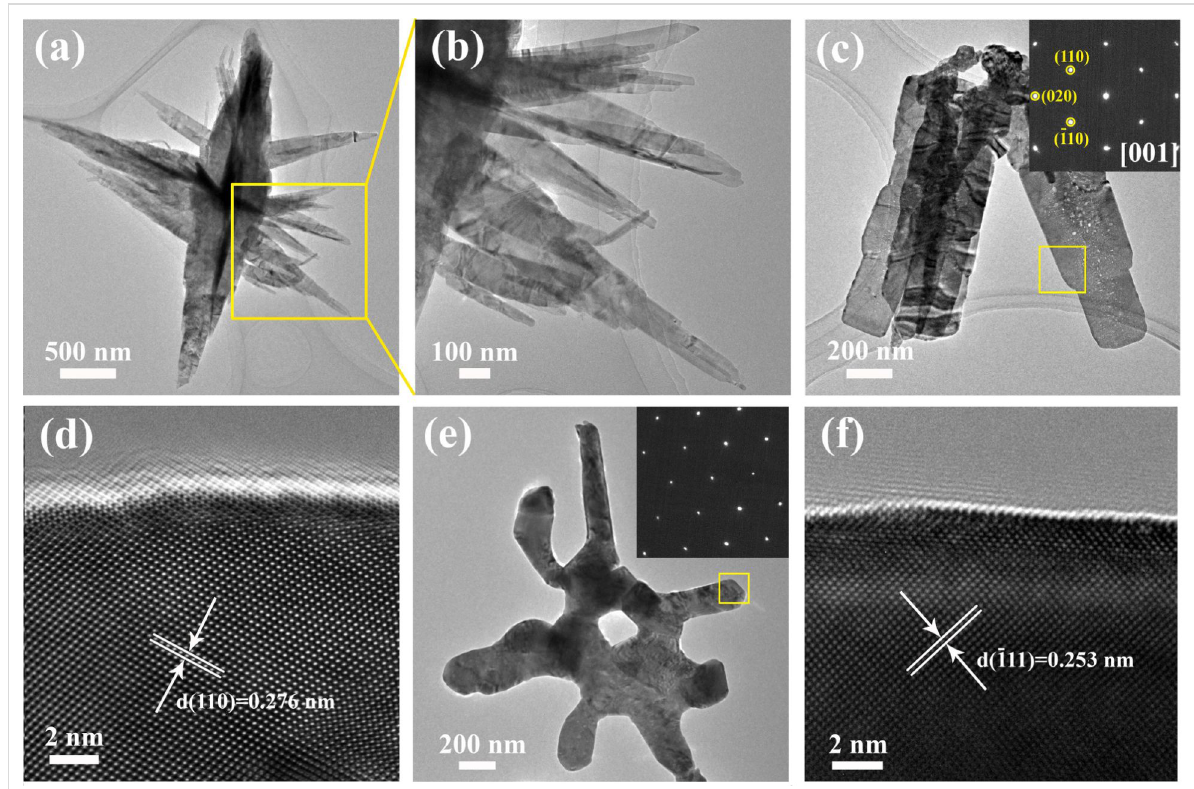
Figure 2: CuO catalyst characterization. (a,b) TEM images of CuO NWs; (c) TEM image of CuO NBs (inset is the SAED pattern of the selected yellow square area); (d) HRTEM along the [1] direction; (e,f) TEM images of a CuO nanobelt after catalysis tests at 650 °C.